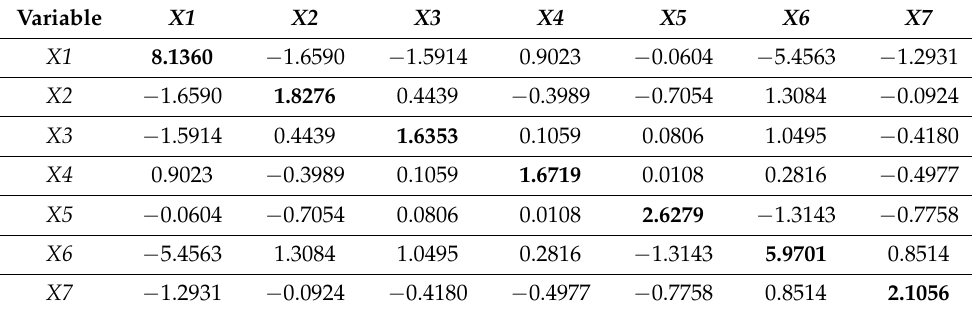
Table 3. Inverse correlation